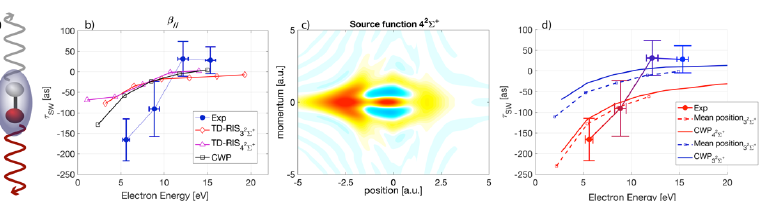
Fig. 1. Stereo Wigner time delay (SWTD). a) Illustration of the SWTD definition. b) Experimental SWTDs (blue) are compared with the dominant channels calculated with the TD-RIS (pink and red) and the CWP (black) method. c) The source function, i.e. the coordinate and momentum representation of the electron wave packet at the instant of birth. d) A comparison between the experimental SWTDs (circles) and the theoretical SWTDs. The solid curves refer the SWTD based on the classical propagation of the electron using the CWP. Dashed curves are the SWTDs retrieved using eq.